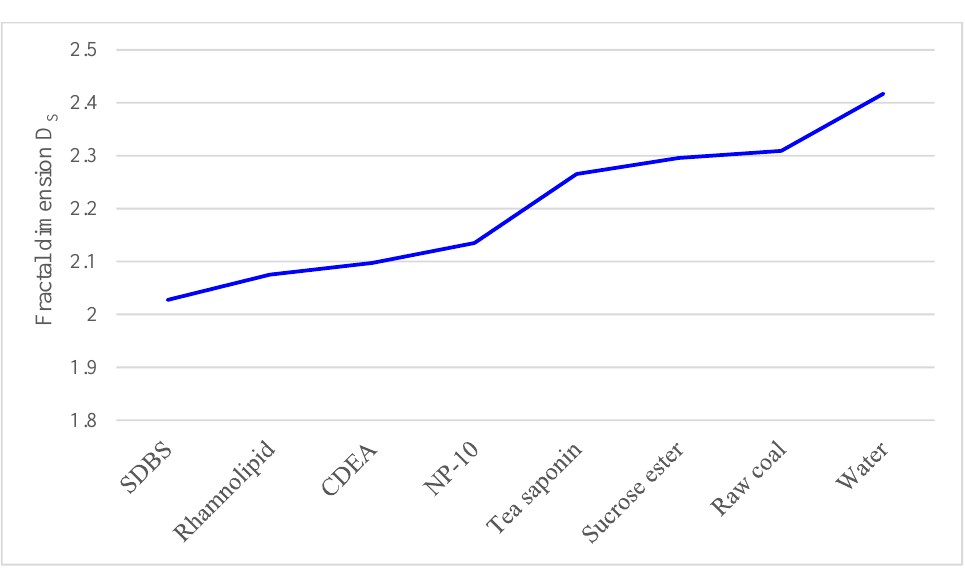
Figure 10. Coal desorption capacity after using surfactants from the perspective of fractal dimensions (the lower D S value, the better coal desorption capacity).